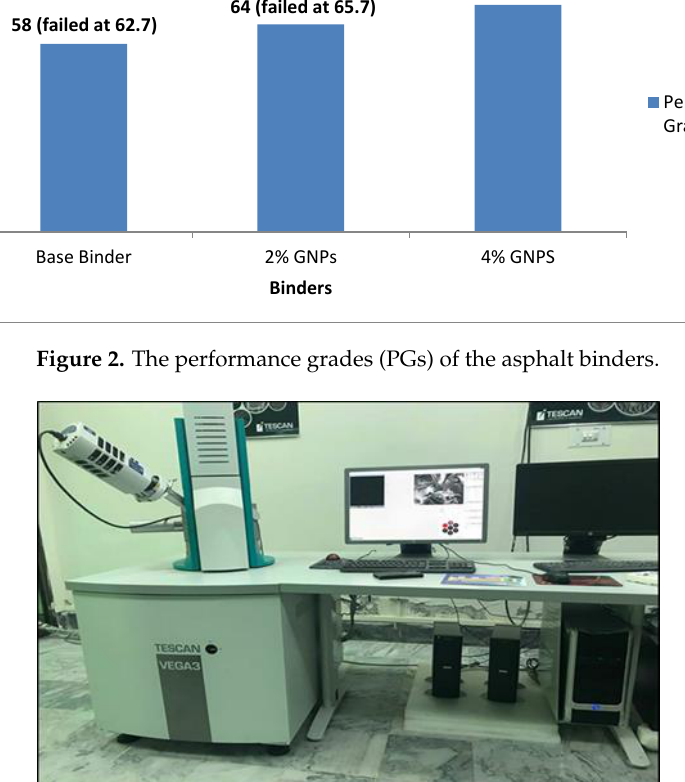
Figure 2. The performance grades (PGs) of the asphalt binders.